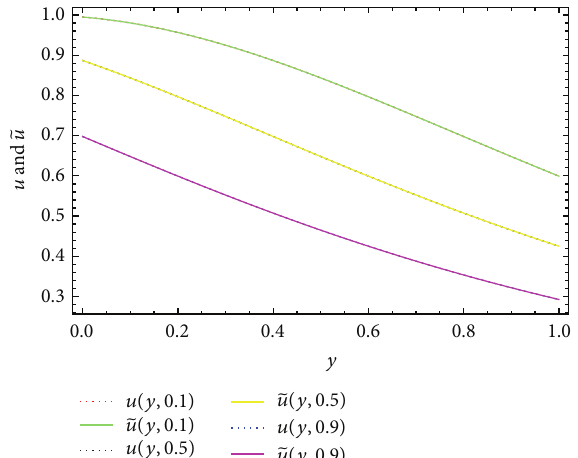
Figure 7: The absolute error 𝐸 1 of problem (51), where 𝑁 = 12 and 𝛼 = 𝛽 = −(1/2) in the interval [0,1] .